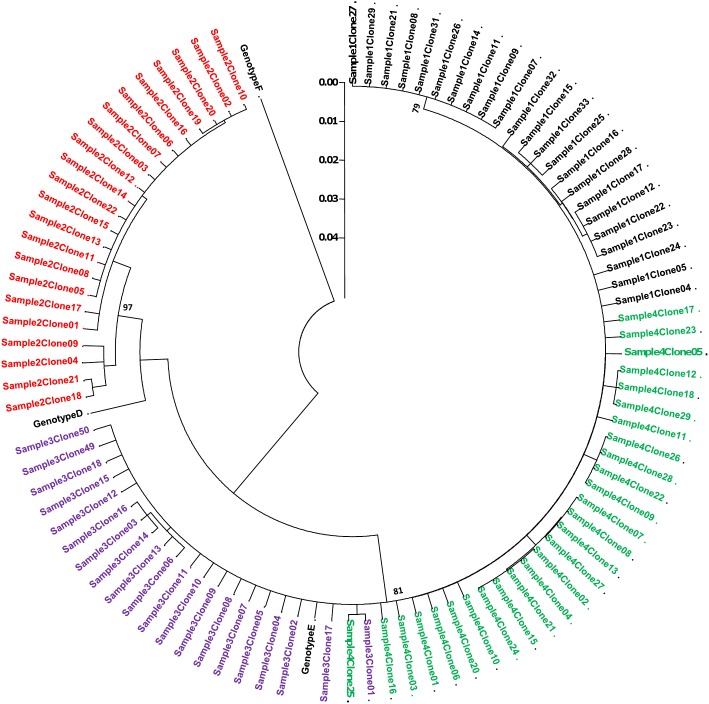
A rooted phylogenetic tree of 92 cloned BCP/PC sequences (position 1653 to 1939 from EcoRI site) from four serum samples.Sample #1 was HBeAg-negative and infected with genotype E of HBV, sample #2 was HBeAg-negative, genotype D, sample #3 was HBeAg-positive, genotype D and sample #4 was HBeAg-positive, genotype E. Bootstrap statistical analysis was performed using 1000 datasets, indicated as percentages on the nodes. The letters, D and E, represent the genotypes.